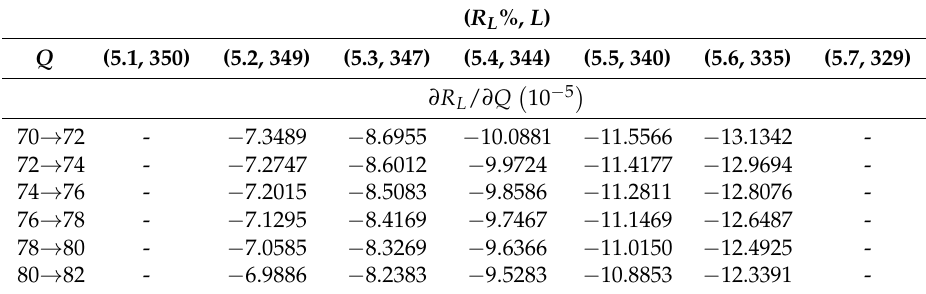
Table 2. Responsiveness of bank interest margin to ELs 1